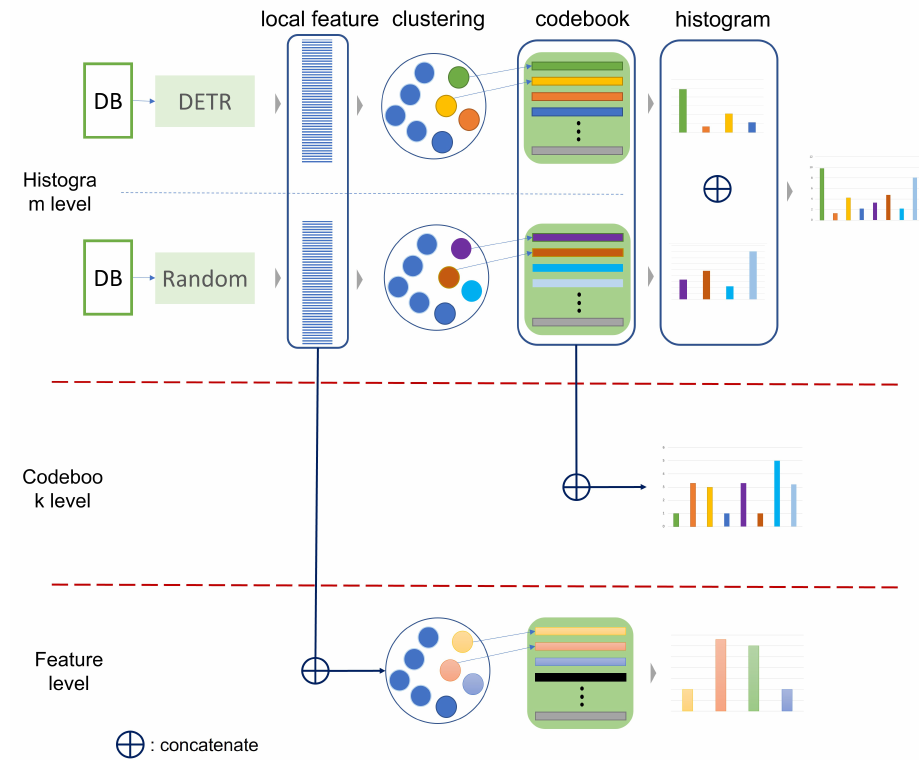
Figure 9. The overview of feature fusion methods. We combine local feature, codebook, and histogram representing different aspects. We state these as feature-, codebook- and